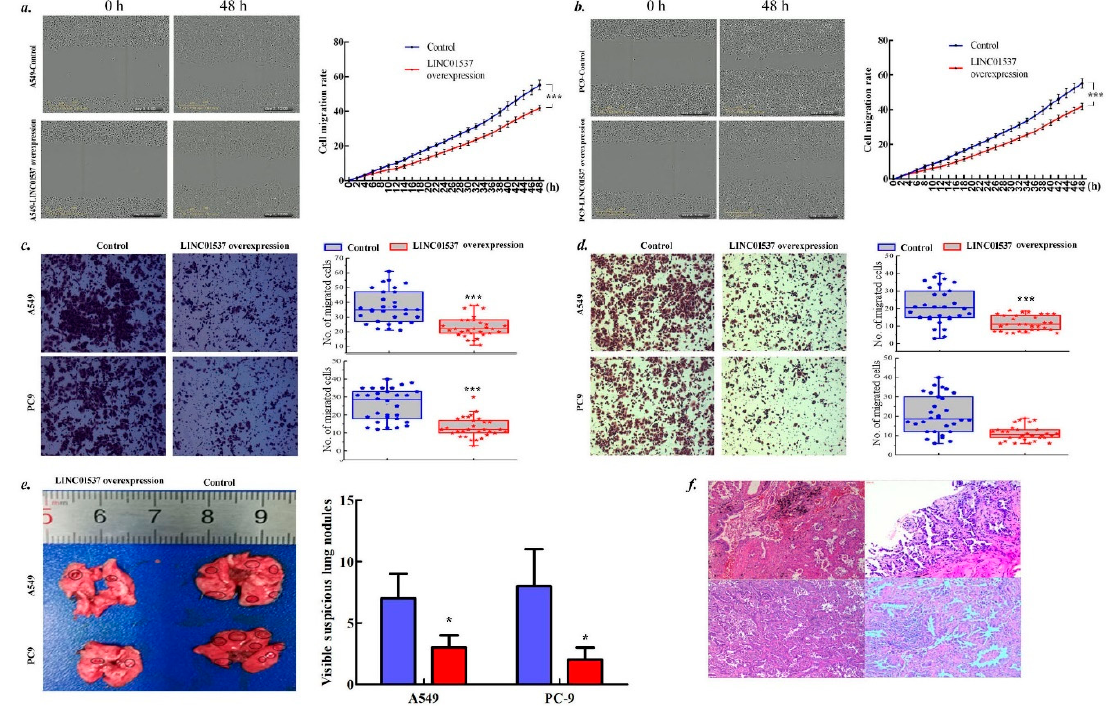
Figure 3. Biologic effects of LINC01537 on cell metastasis. Both A549 and PC9 cells were transfected with pEZ-Lv201-LINC01537 (LINC overexpression) and pEZ-Lv201-Empty (Control). ( a – b ). The wound healing was used to test cell migration in A549 cells ( a ) and PC9 cells ( b ) in vitro . ( c – d ). Transwell assay was applied for determining cell migration ( b ) and invasion ( c ) in vitro . ( e ). The tail vein infection experiment determined lung nodule in vivo . f. The IHC (Immunohistochemistry) confirmed the nodule harboring LUAD clinicopathological features. Circle dot on line ( a ) or bar height ( c – e ) corresponds to the mean, and error bars represent the SD for five ( a, b ), three ( c – e ) biological replicates. * p < 0.05, ** p < 0.01, *** p < 0.001, calculated by the Student’s t test.